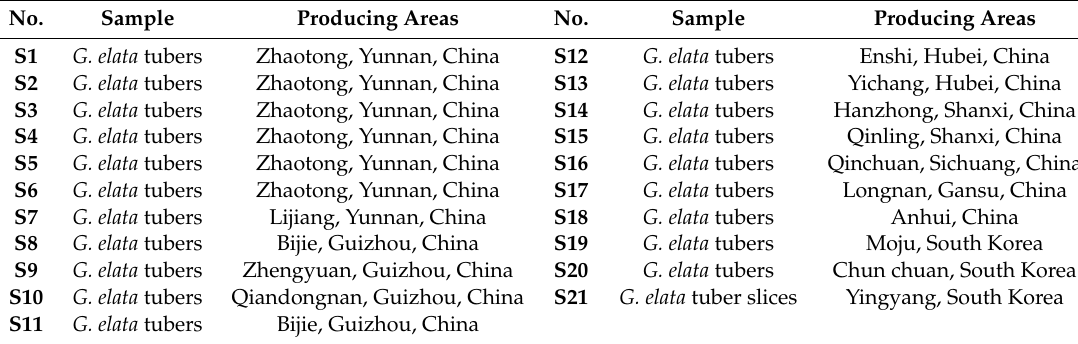
Table 8. The information of G. elata tubers from di ff erent producing areas.